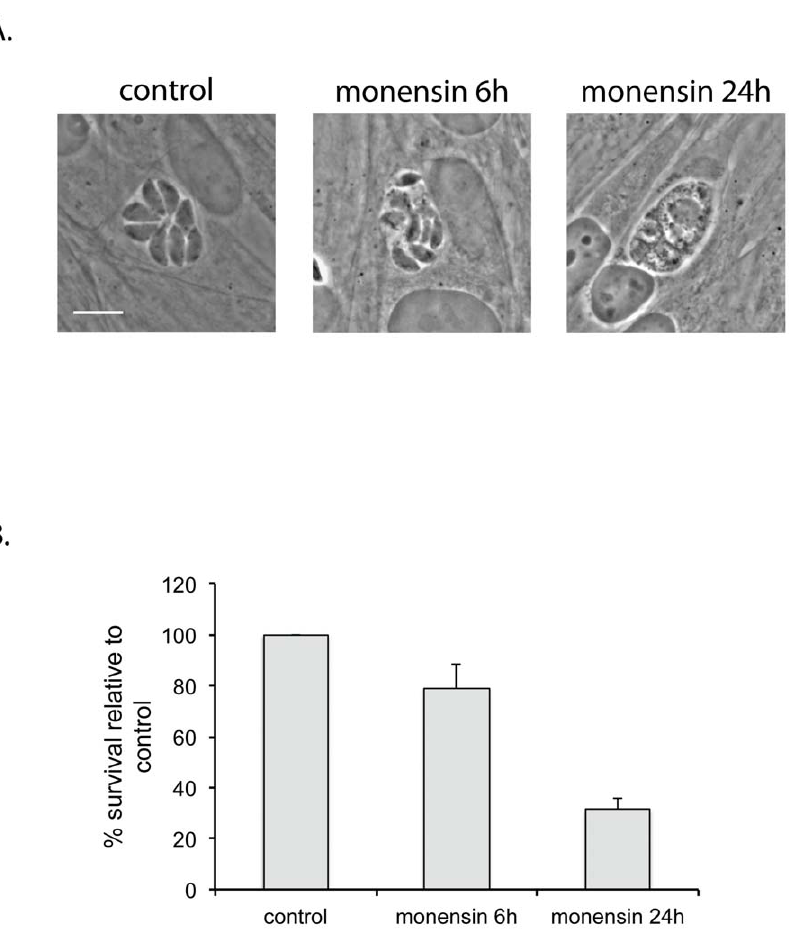
Figure 1. Effect of monensin on T.gondii is reversible. (A) Phase-contrast micrographs of intracellular T. gondii after exposure to 0.75 ng/ml monensin for 6 hours or 24 hours. By 24 hours 100% of parasites show the altered appearance pictured. Scale bar=10 m m. (B) Survival of T. gondii after exposure to monensin. Parasites were exposed to 0.75 ng/ml monensin for 6 hours or 24 hours, after which the monensin was removed and parasites were allowed to form plaques. Data is expressed as % survival relative to control (no-monensin exposure) parasites. Control parasites are considered to have 100% survival. Each bar represents the mean value for three independent replicates. Error bar=1 standard deviation.